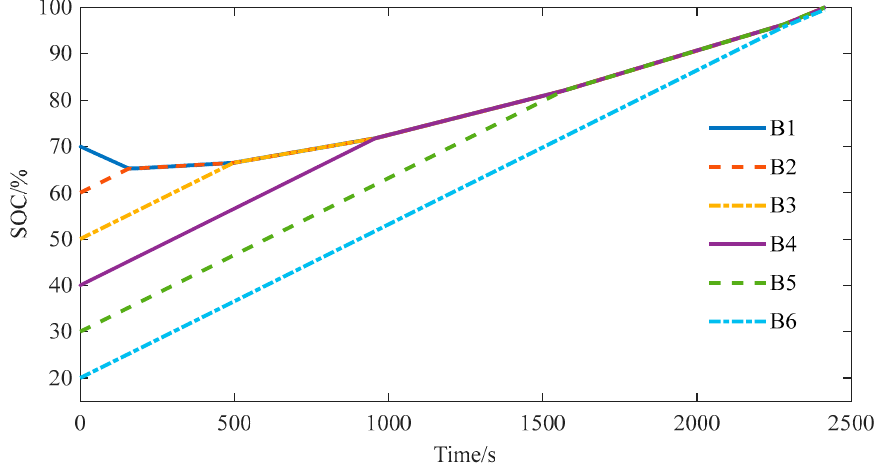
Figure 15. Equilibrium results of peak clipping scheme under charging condition.